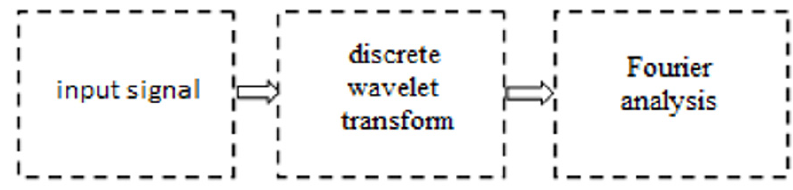
Figure 2. Diagram of the hybrid method of the time-scale-frequency analysis.